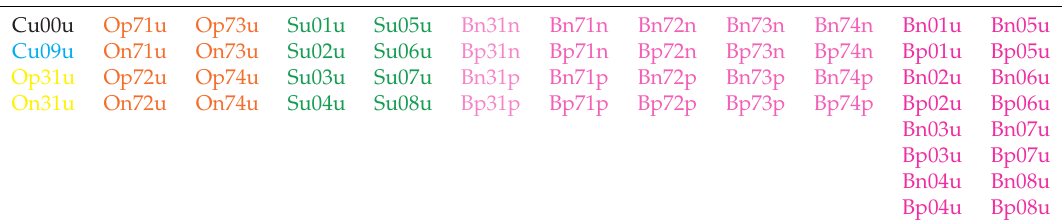
Table 1. Labeling used to identify each ensemble member. The color represents the source of the members’ perturbation: control (black), control with [29] setup (cyan), CV3 covariance matrix (yellow), CV7 covariance matrix (orange), SKEBS (lavender), breeding (carnation pink), and breeding unsigned from SKEBS (rhodamine).